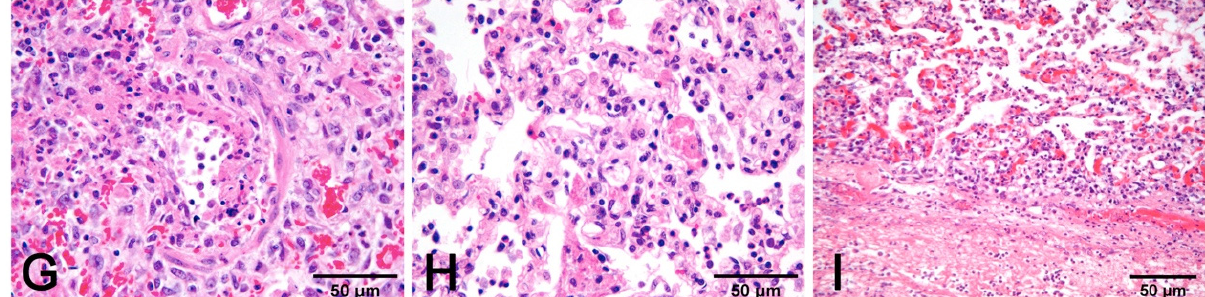
Figure 7. Pneumonia with alveolar macrophages ( A ) and lymphocytic peribronchial cuffing ( B ); when associated with gross changes in cranioventral non-complicated pneumonia, these histological findings are indicative of EP. Increase in airway and alveolar neutrophils ( C ) indicates complication. Necrosis of lung parenchyma ( D ) and of alveolar cell exudate ( E ), fibrin alveolar collection ( F ) associated with vessel fibrinoid necrosis ( G ), thrombosis ( H ), and fibrinous pneumonia ( I ) are a histologic indication of porcine pleuropneumonia, for which etiologic indication is imperative, as similar gross and histologic changes are also due to bacteria different from Actinobacillus pleuropneumoniae . ( A – E , G – I ): H–E stain. ( F ): PTAH stain.